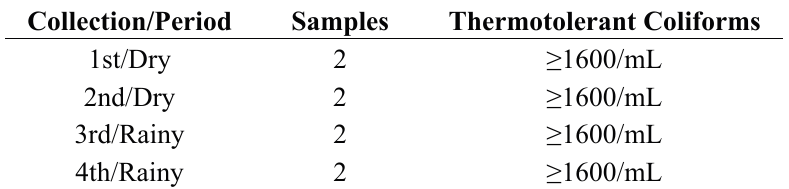
Table 1. Most Probable Number (MPN) of thermotolerant coliforms per 100 mL of water samples from the Jansen Lagoon, during the dry and rainy periods of 2013, São Luís, Maranhão State, Brazil. Collection/Period Samples Thermotolerant